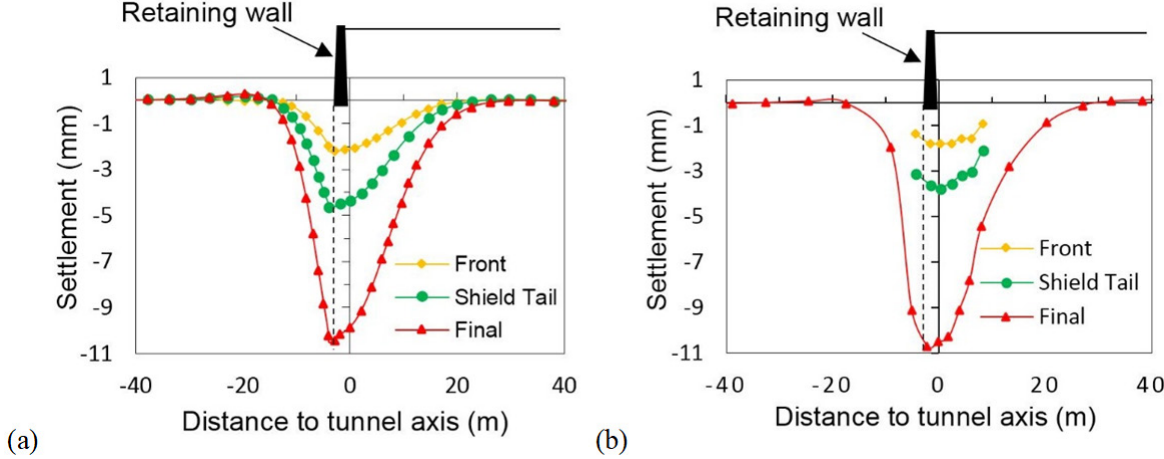
Figure 11: Transverse settlement troughs at different phases: (a) simulations and (b) field